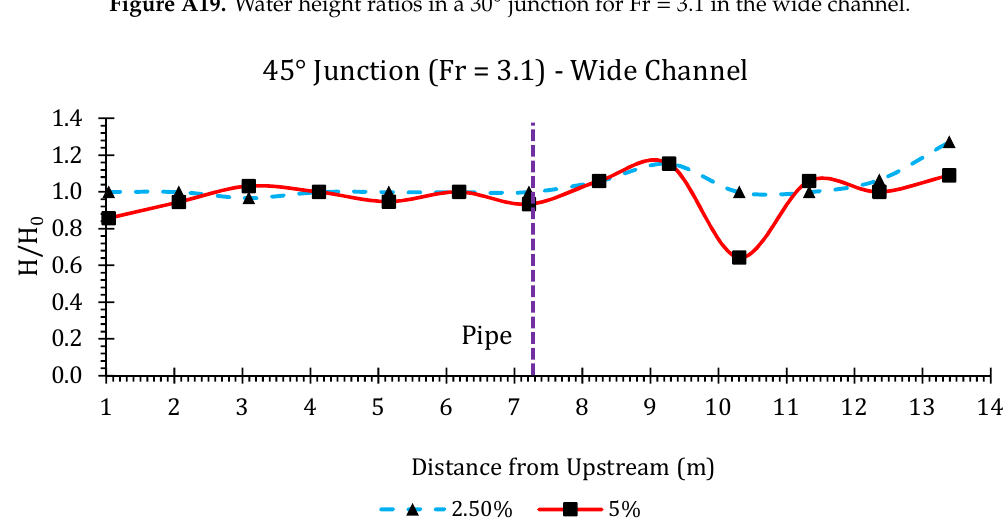
Figure A20. Water height ratios in a 45 ◦ junction for Fr = 3.1 in the wide Figure A20. Water height ratios in a 45° junction for Fr = 3.1 in the wide channel. Figure A20. Water height ratios in a 45° junction for Fr = 3.1 in the wide channel. Figure A20. Water height ratios in a 45° junction for Fr = 3.1 in the wide channel.